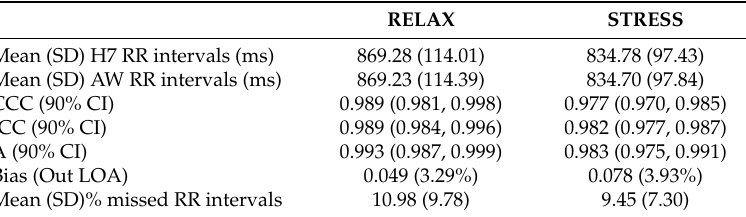
Table 1. Validity of RR series from Apple Watch. CI = Confidence interval.